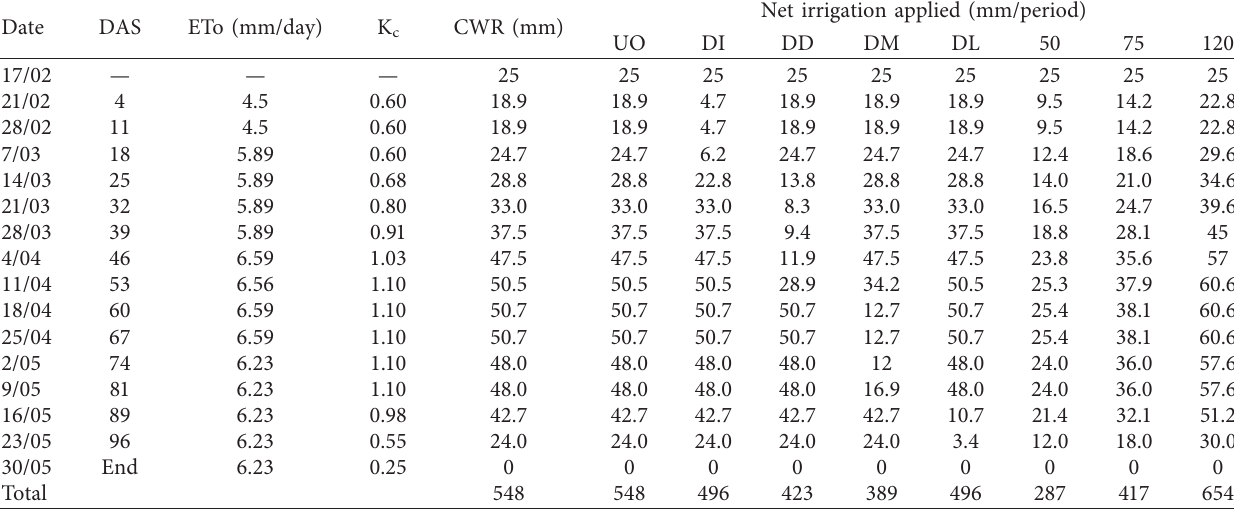
Table 4: Crop water requirement and depth of irrigation water application (mm) on weekly bases.